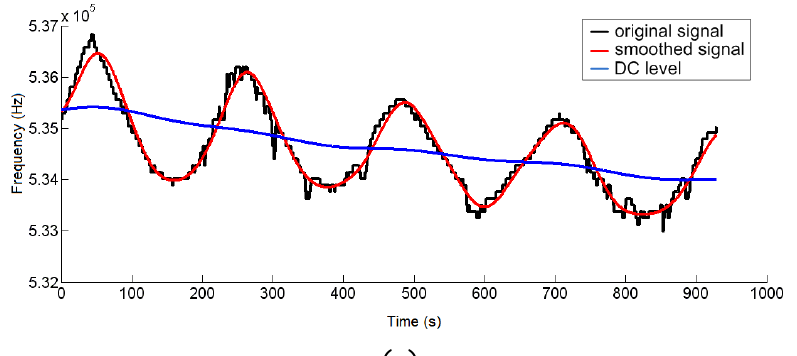
Figure 8. Resulting respiratory signal after second-stage processing of both